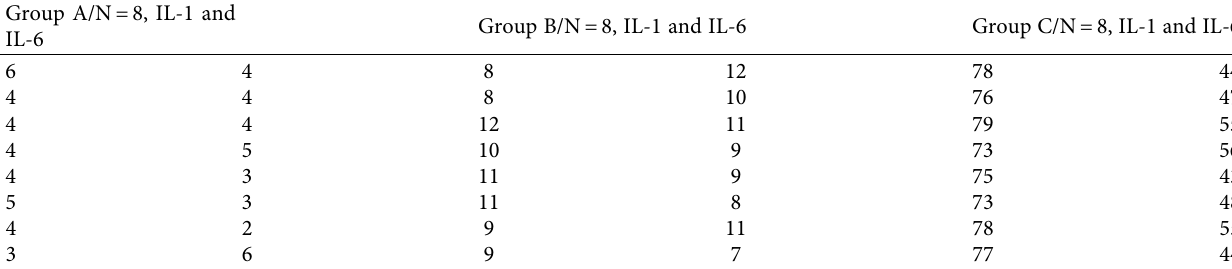
Table 1: Interleukin 1 and interleukin 6 levels in mice.